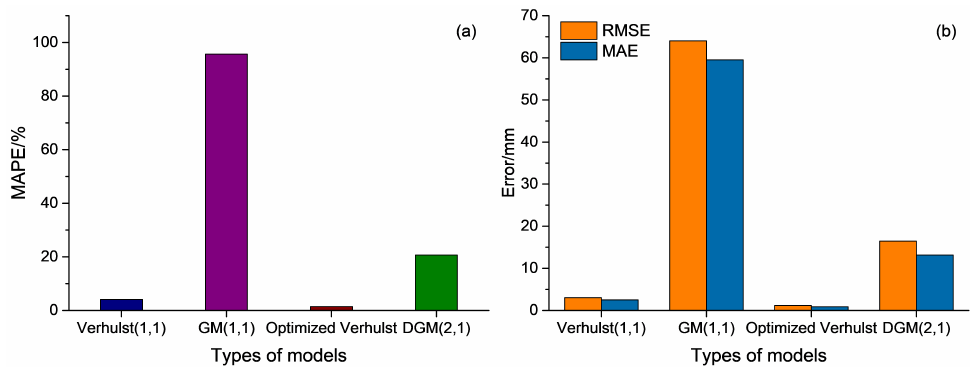
Figure 5. Error histogram between the original measured value and prediction values of four prediction models from Dec-2010 to Sep-2011 (next 10 testing sample data). ( a ) MAPE; ( b ) RMSE and MAE.